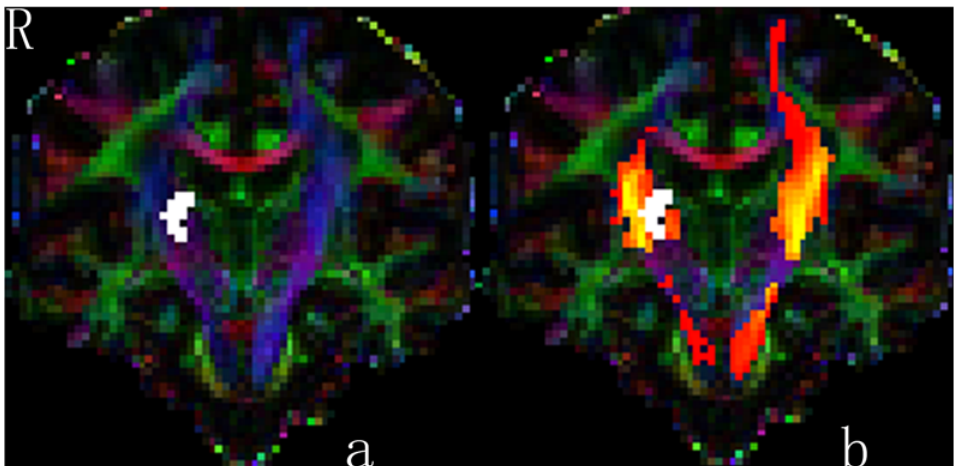
Fig 1. Coronal views of individual color-coded FA map (a) and postprocessed CST map (b) of subject 03 in our study. The patient ’ s UM-FM score was 25 and time after stroke was 9.7 months. The postprocessed CSTs map (the color of red-yellow in the Fig b) was overlayed with actual CSTs map (the blue color in the Fig a). The infarct (white color) is just inside the right CST and the volume of the ipsilesional CST decreased contrasted with the contralesional one. FA ratio is 0.88. Colors indicate direction of fiber tracts (red, left – right; blue, cranio-caudal; green, anterior – posterior).